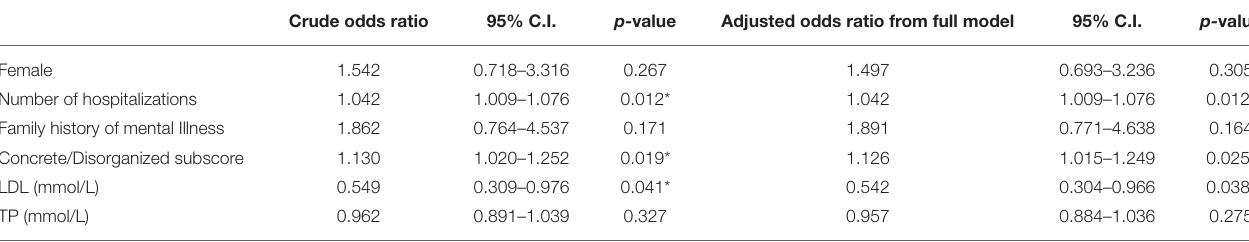
TABLE 3 | Risk factors for QTc prolongation by binary logistic regression.